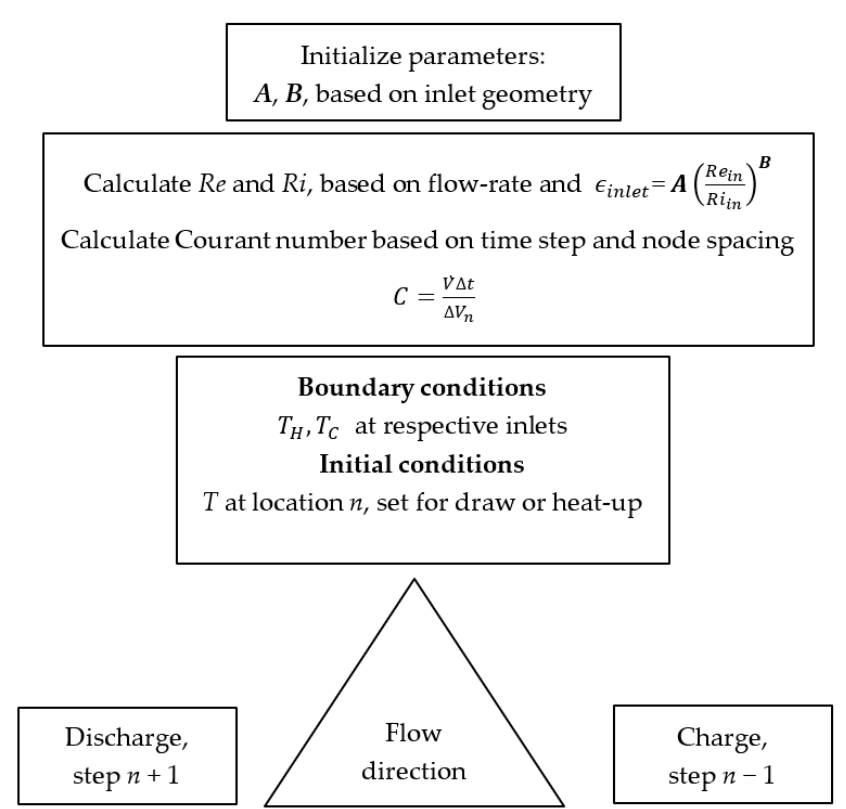
Figure 2. Computational flow diagram for discharge and charge of a stratified hot-water tank with empirical data for the relationship of (cid:101) inlet and coefficients A and B